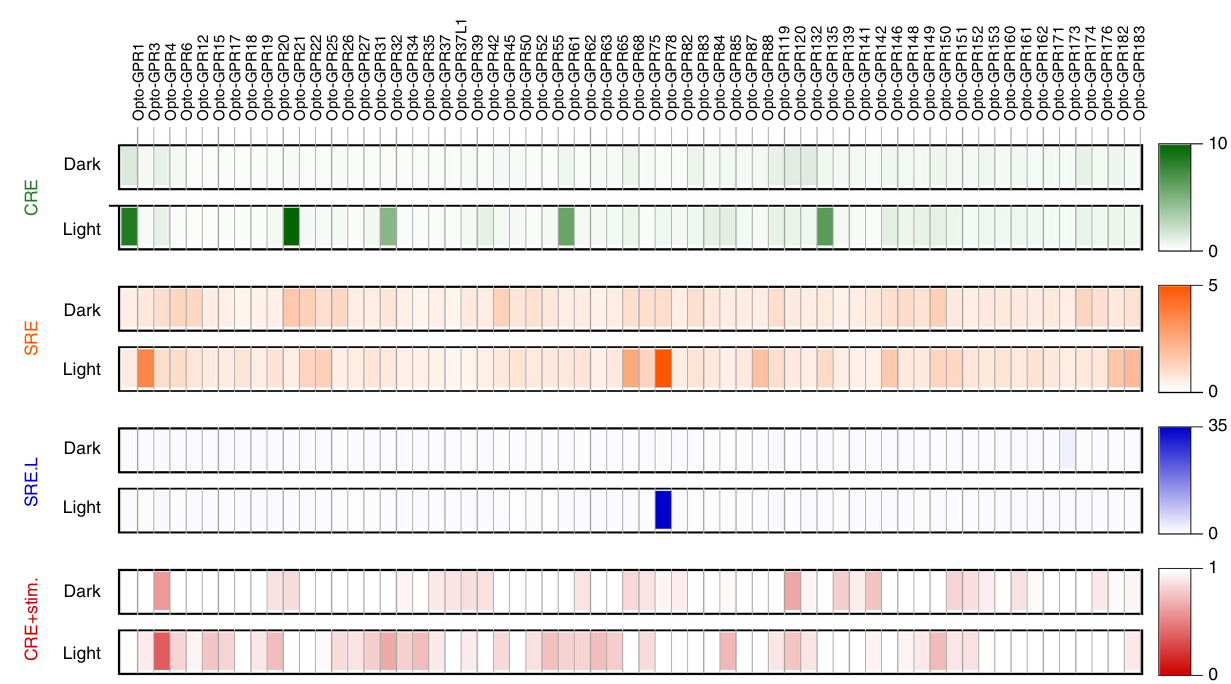
Fig. 3 Optical functionalization of 63 human GPCRs. Reporter activation by chimeric receptors stimulated with light. Squares are fi lled with false color representations of mean FF RLU/RE RLU norm. values ( n = 6 – 8, 3 – 4 independent experiments), as indicated by the scale bars. Also see